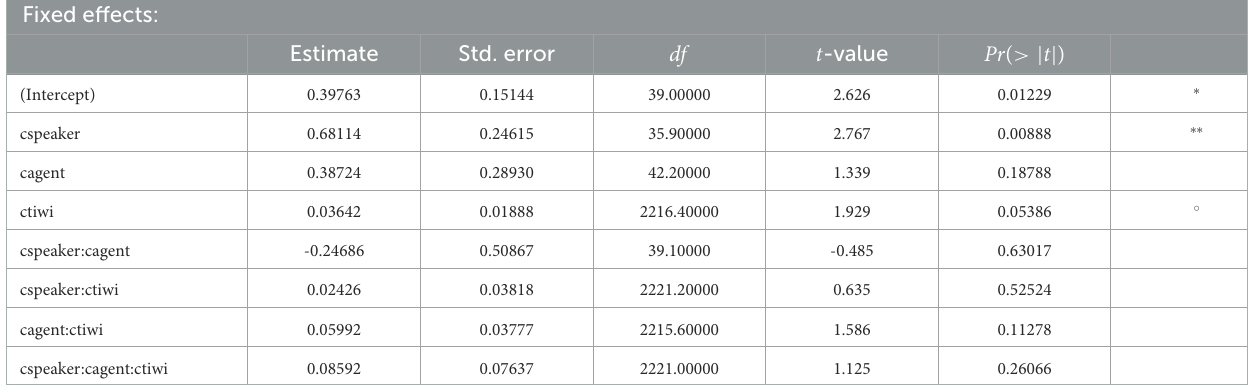
TABLE 8 Coefficients, SE s, df s, t -values, and p -values for the optimal model of logratios of target fixations for the NP2 time window in Experiment